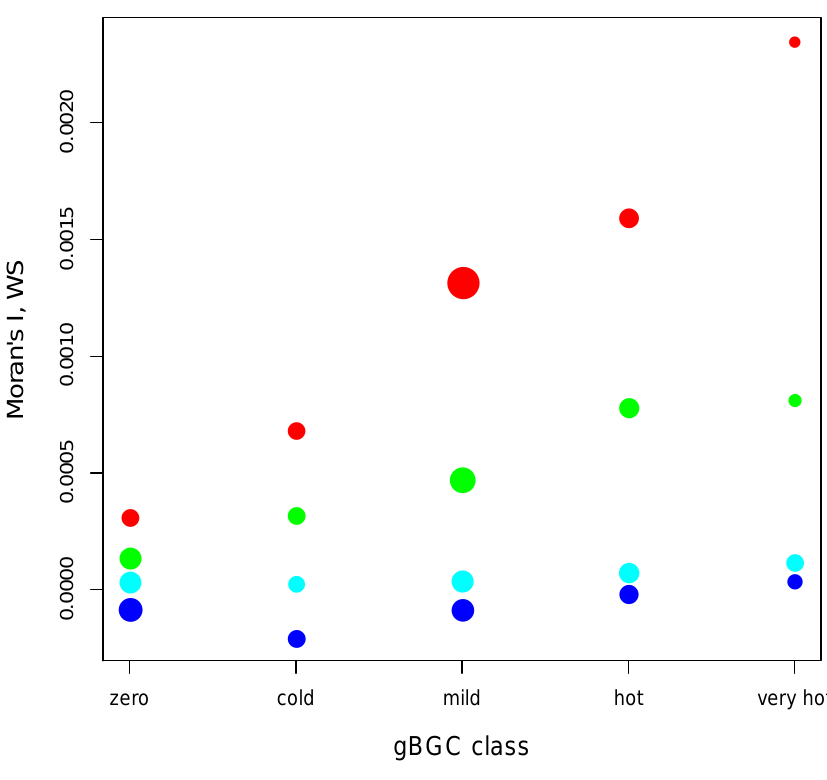
Figure 5 – Average centered Moran’s I as a function of average estimated gBGC strength B . Each dot is for a class of genes in a family (all species merged). Genes were assigned to classes under the M5f model. Dot size reflects the relative number of genes in the considered class. Blue: Hominidae; cyan: Cercopithecidae; green: Bovidae; red: Muridae.